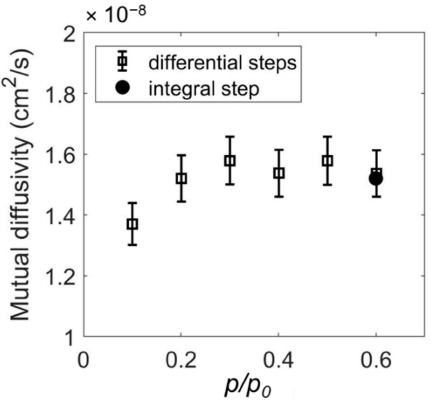
Figure 4. Fick’s plots ( A ( t )/ A ( ∞ ) vs interval 0–0.6.